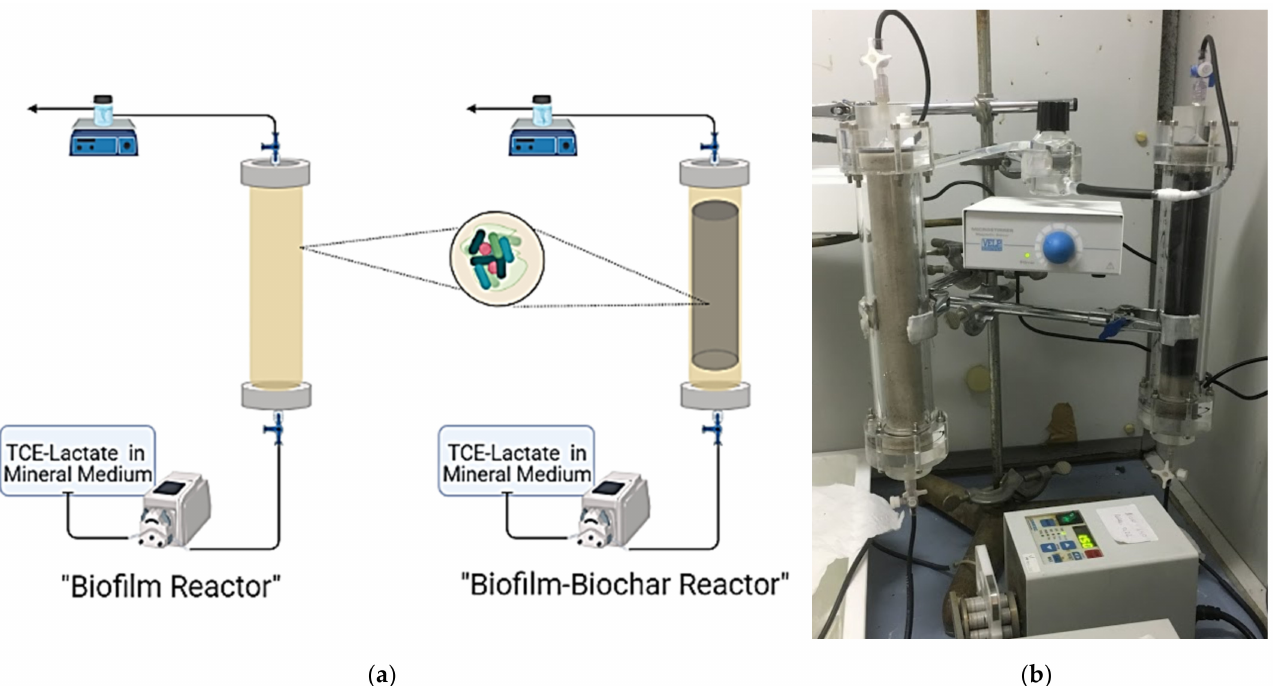
Figure 1. ( a ) BR and BBR setup; ( b ) a photograph of the BR (on the left) and BBR (on the right). Before dechlorinating the biomass addition, a tracer test was performed with KBr (100 mg/L Br − ) and NaCl (0.02 M), for the BR and BBR respectively. Porosity and bed volume (BV) was calculated as described in Rossi et al. (2021) [46]. The flow rate was measured daily; hence, Table 1 shows the average values over the investigated period and the parameters consequently calculated. Afterwards, an active dechlorinating culture (100 mL) was injected into the BR and BBR by the inlet three-way valve and recirculated for at least 48 h for the biofilm’s stabilization. The feeding solution was prepared in Tedlar ® bags (Supelco, Bellefonte, PA, USA) to avoid headspace formation. The solution consisted of anaerobic mineral medium (flushed with N 2 /CO 2 gas mixture), TCE (0.1 mM), and lactate (0.2 mM). The initial concentration (TCE IN) was verified by periodically sampling from the Tedlar ® bag’s septum. All of the reactors operated at room temperature (15–22 ◦